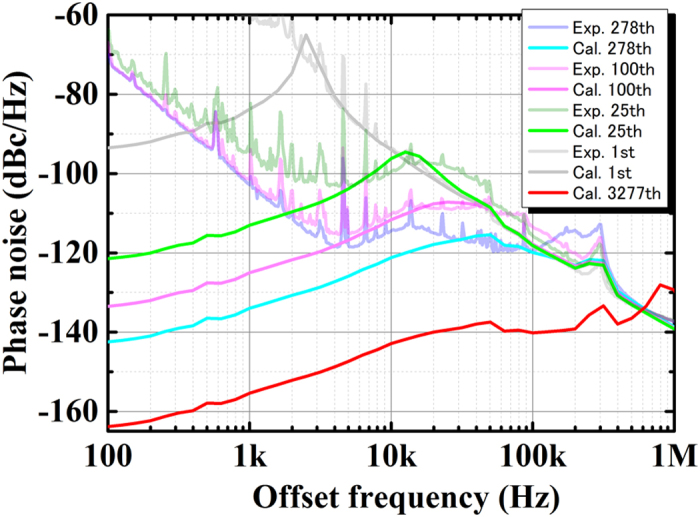
Simulated phase-noise spectra of 25-GHz millimetre waves.Calculated phase noise φ1(t) obtained when feeding back with the 1st mode (grey trace), 25th mode (green trace), 100th mode (pink trace), 278th mode (blue trace) of the EOM-OFC. As reference traces, the experimental phase-noise spectra (Fig. 2a) are shown by the faintly coloured curves.